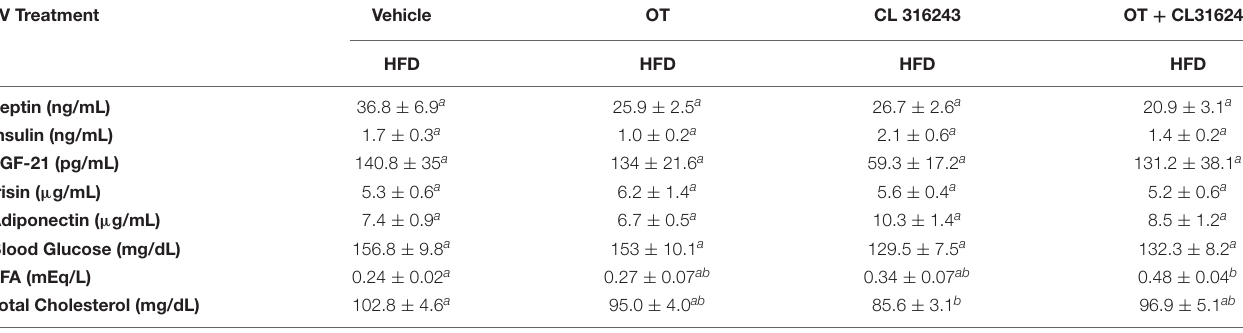
TABLE 5 | Plasma measurements following 4V infusions of OT (16 nmol/day), CL 316243 (0.5 mg/kg), or OT (16 nmol/day) + CL 316243 (0.5 mg/kg) in DIO rats.